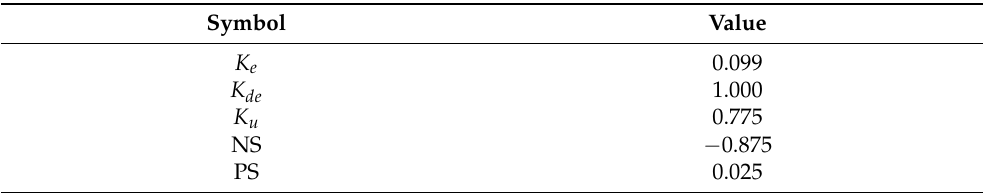
Table 3. Optimized parameters of position FLCS.